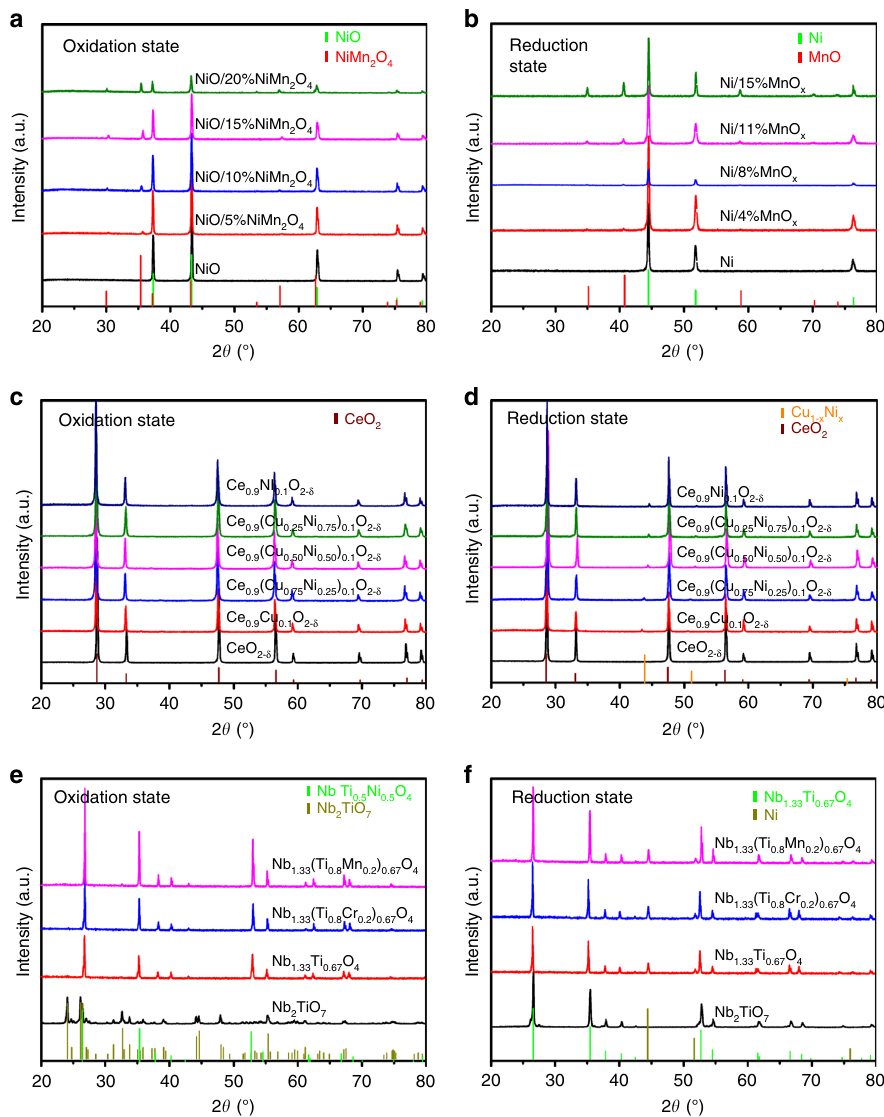
Fig. 1 X-ray diffraction patterns of samples. a Oxidized samples of NiO/ x %NiMn 2 O 4 ( x = 0, 5, 10, 15, 20). b Reduced samples of Ni/ y %MnO x ( y = 0, 4, 8, 11, 15). c Oxidized and d reduced samples CeO 2 and Ce 0.9 (Cu 1 − x Ni x ) 0.1 O 2 − δ ( x = 0, 0.25, 0.5, 0.75, 1). e Oxidized and f reduced samples Nb 2 TiO 7